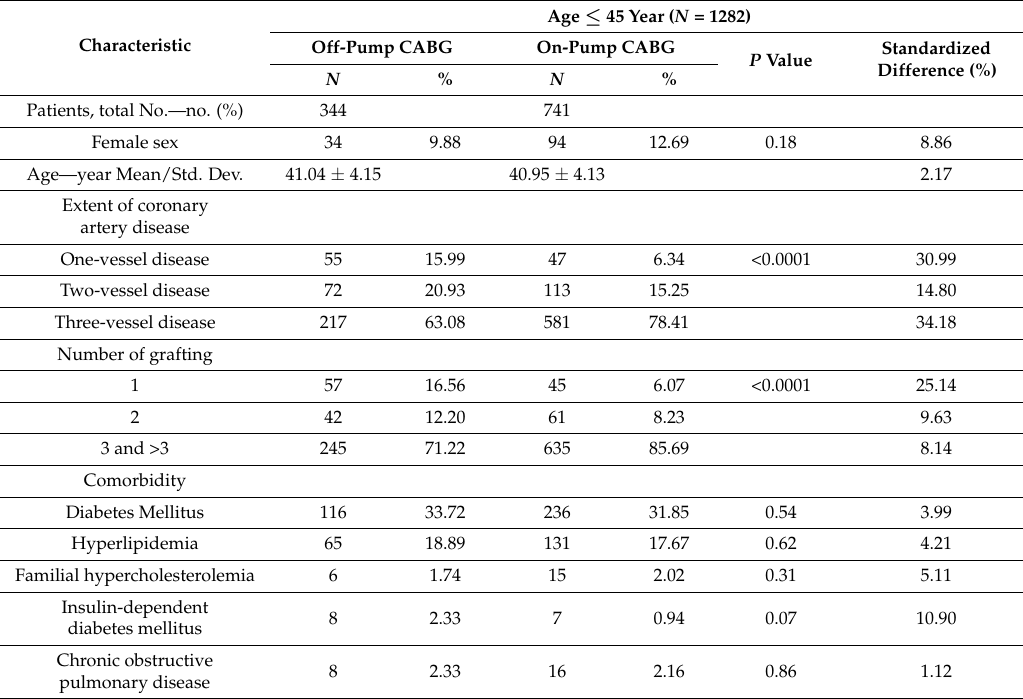
Table 1. Baseline characteristics of the